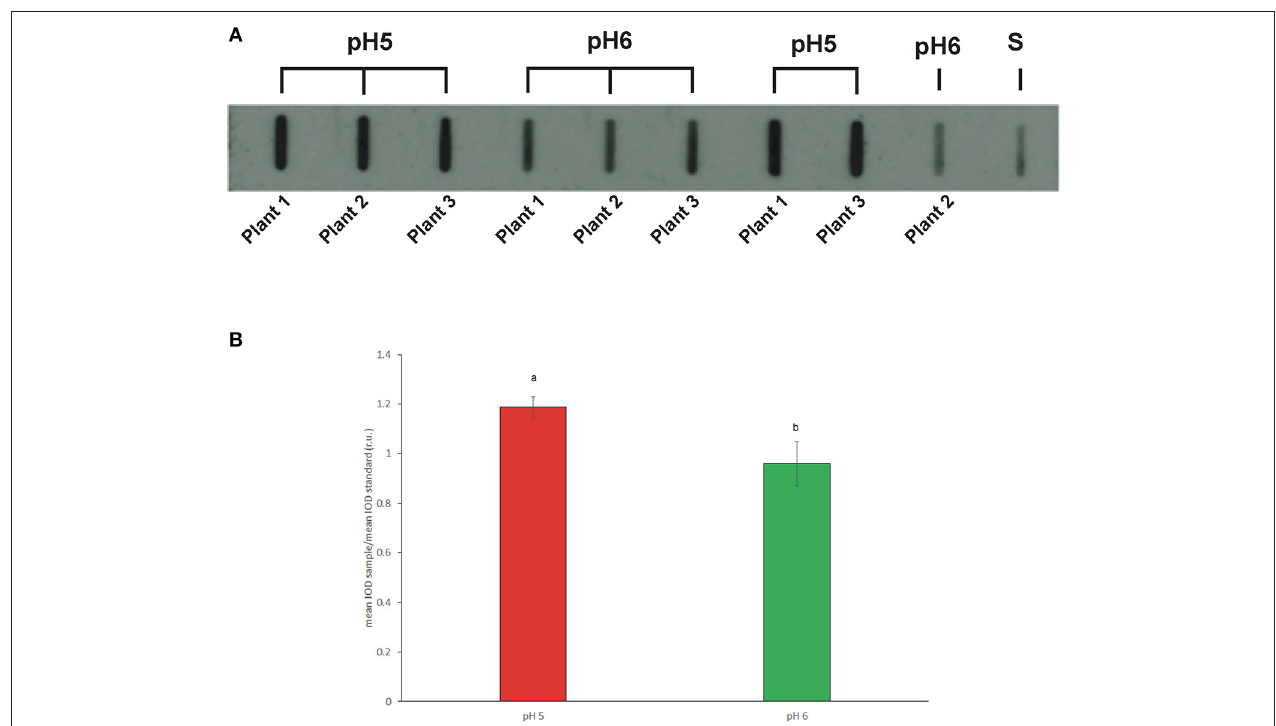
FIGURE 5 | (A) Representative slot blot membrane probed with a pool of selected patient sera showing the total allergenicity of pollen samples collected from plants grown in soils at pH5 and pH6. Pollen proteins obtained from single plants by independent extractions were loaded. (S) Standard (protein extract from commercial pollen, Allergon); (B) Mean total allergenicity of pollen collected from plants grown at pH5 and pH6. Image analysis was applied to measure the integrated optical density (IOD) of immunoreactive spots with respect to the IOD of the standard (sample IOD/standard IOD). Different letters indicate significant differences between treatments at P < 0.05